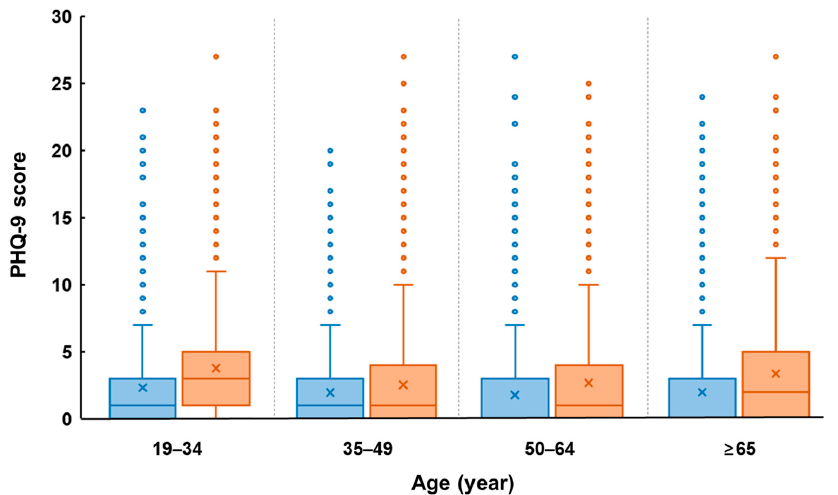
Figure 2. A box and whisker plot of PHQ-9 scores by gender and age. The horizontal line inside the box represents median, and the ‘x’ symbol represents mean. box represents median, and the ‘x’ symbol represents